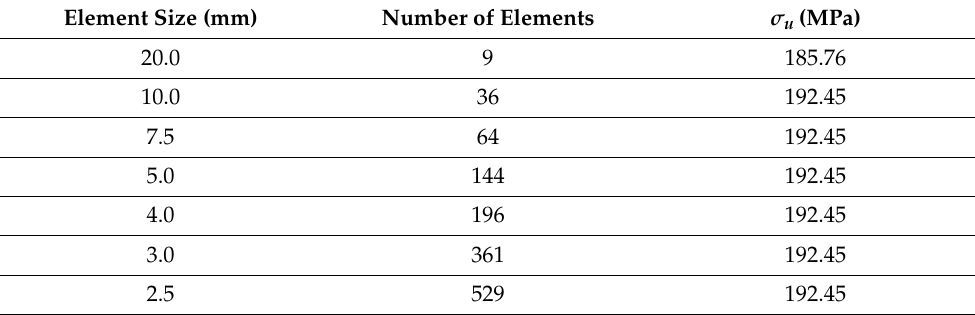
Table 9. Mesh convergence test for the validation of the computational model by Shanmugam and Narayanan [25].